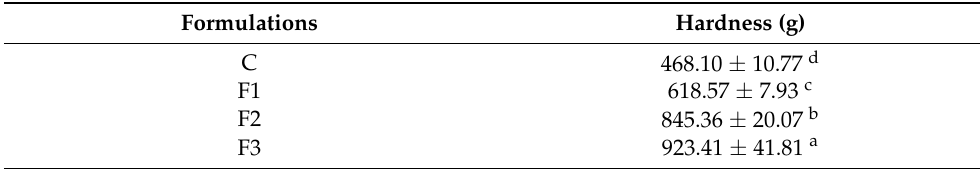
Table 5. Hardness of control and GABA-enriched dark